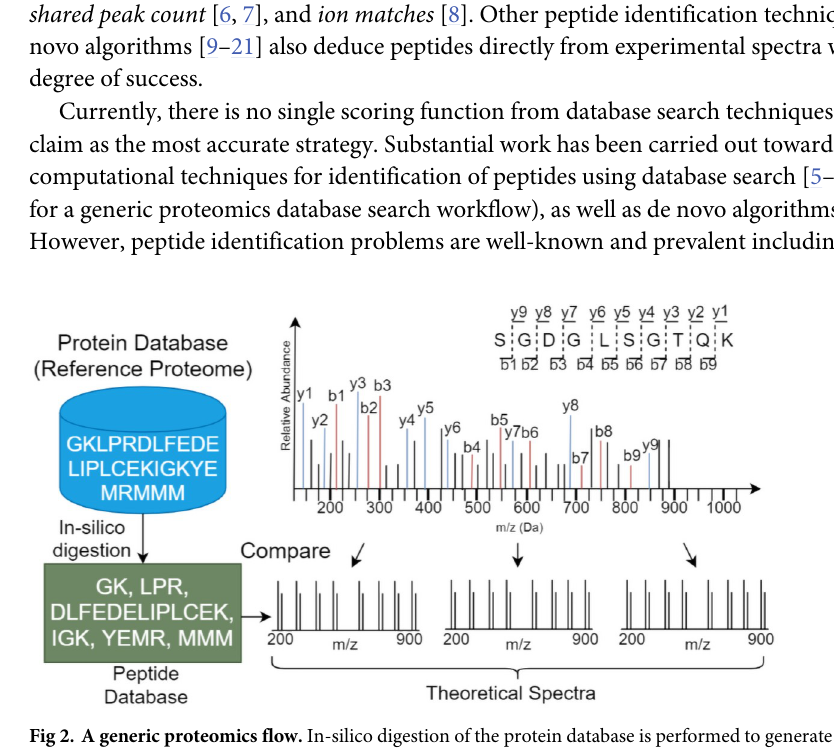
PLOS ONE | https://doi.org/10.1371/journal.pone.0259349 October 29,